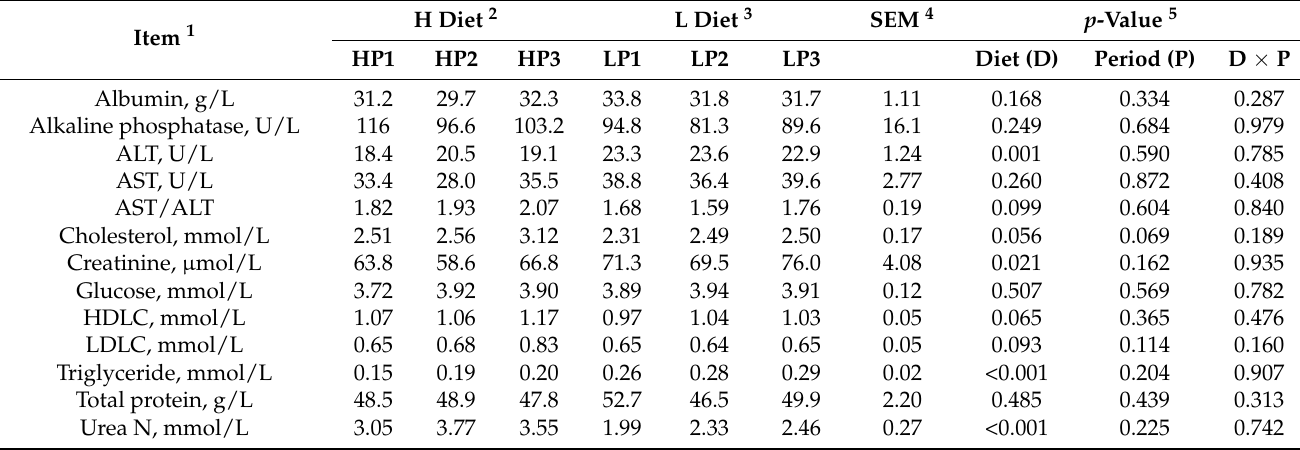
Table 3. Serum metabolic parameters over three collection periods in high- and low-density